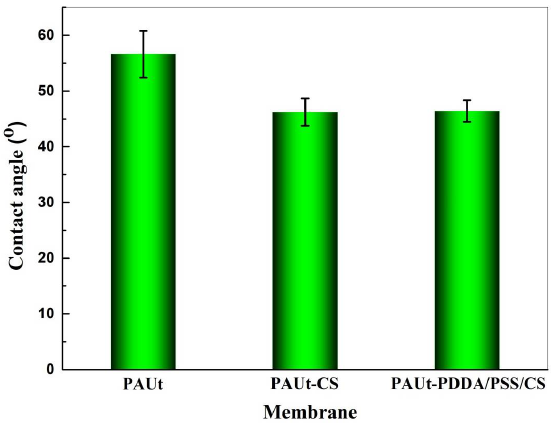
Figure 6. Water contact angle of the membranes.